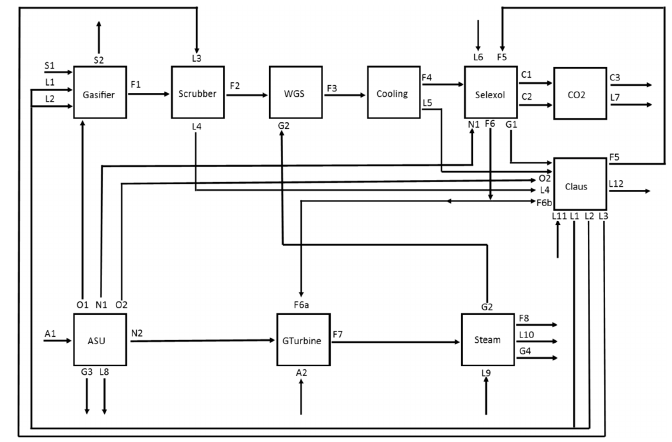
Figure 1. Baseline Model process flow diagram, using Field & Brasington, 2011, as starting model.